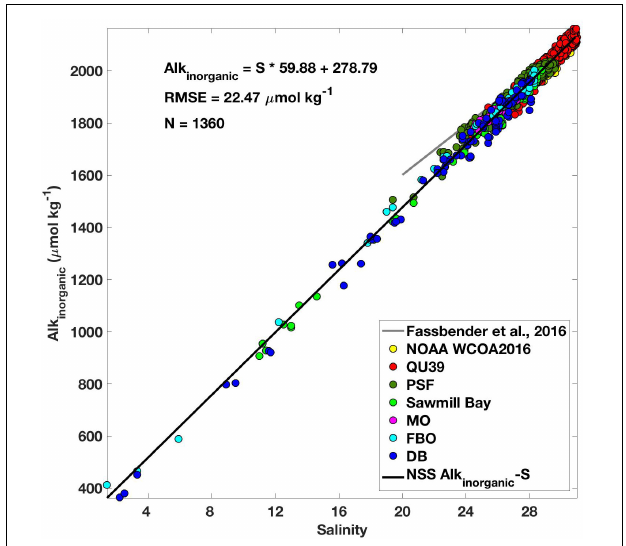
FIGURE 2 | Relationship between alkalinity (Alk inorganic ; µ mol kg − 1 ) and salinity (black line; Alk inorganic = S ∗ 59.88 + 278.79; RMSE = 22.47 µ mol kg − 1 ) developed using 1360 discrete measurements of pCO 2 , TCO 2 , temperature, and salinity collected at oceanographic and aquaculture sites in the NSS (color matched with position in Figure 1 ) between 2016 and 2017. Also shown for comparison is the relationship from Fassbender et al. (2016; gray line) that was constructed using data collected over a salinity range from 20 to